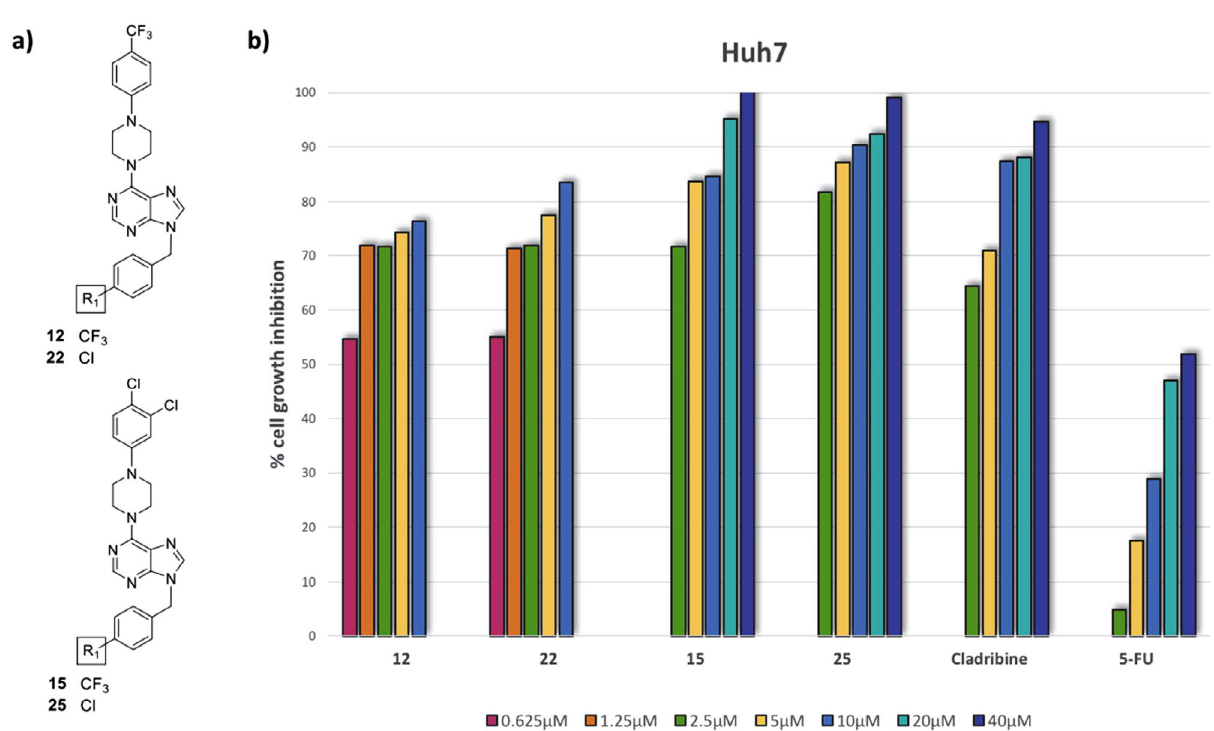
Figure 4. a) Chemical structures of the most active purine analogs 12 , 22 , 15 and 25 b) Percent cell death in the presence of most active compounds ( 12 , 22 , 15 and 25 ). Huh7 cells were inoculated in 96-well plates. All molecules and their DMSO controls were administered to the cells in triplicate with corresponding different concentrations: 0.625, 1.25, 2.5, 5, 10, 20, and 40μM. After 72 h of incubation, SRB assays were generated, and the cell death percentages were calculated in comparison with DMSO-treated